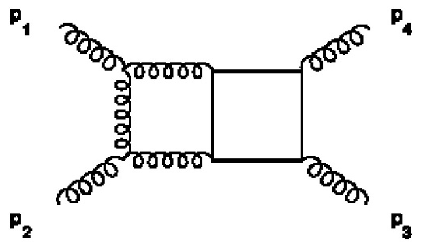
Figure 10. Four points two-loop